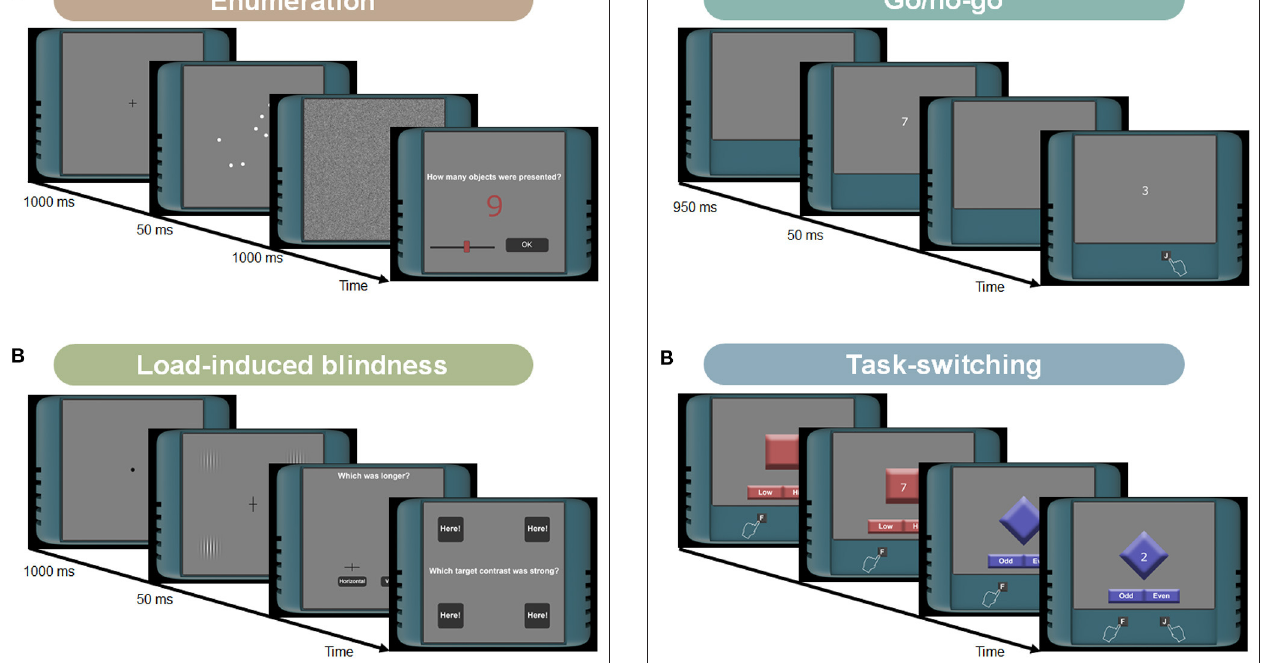
FIGURE 2 | (A) Stimuli and tasks in the enumeration task. After presenting the fixation point, a brief flash of multiple white circles was presented. Participants answered how many circles were shown by using a slider. (B) Stimuli and tasks in the load-induced blindness task. Participants were asked to perform a dual-task, answering the length of the gazing point and the contrast of the images presented in the surroundings. After showing the fixation dot, a cross target with four Gabor stimuli was briefly presented. Participants first answered which of the lines was longer using mouse clicking. Then they answered which of the four Gabor stimuli had the enhanced contrast by clicking one of the four buttons.